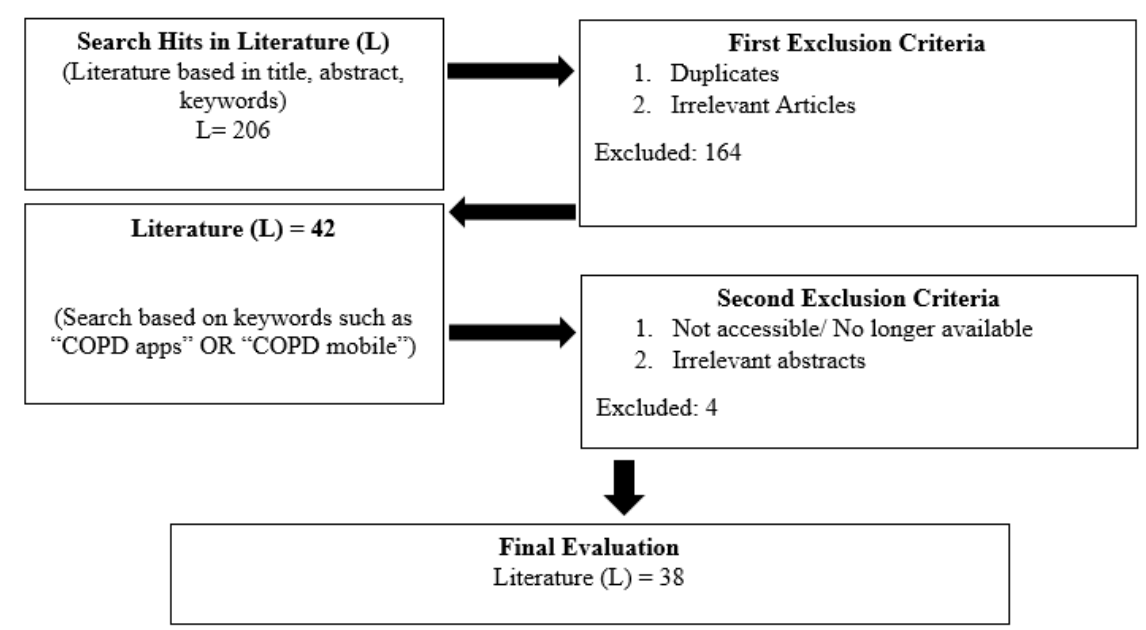
Figure 1. Selection criteria for published